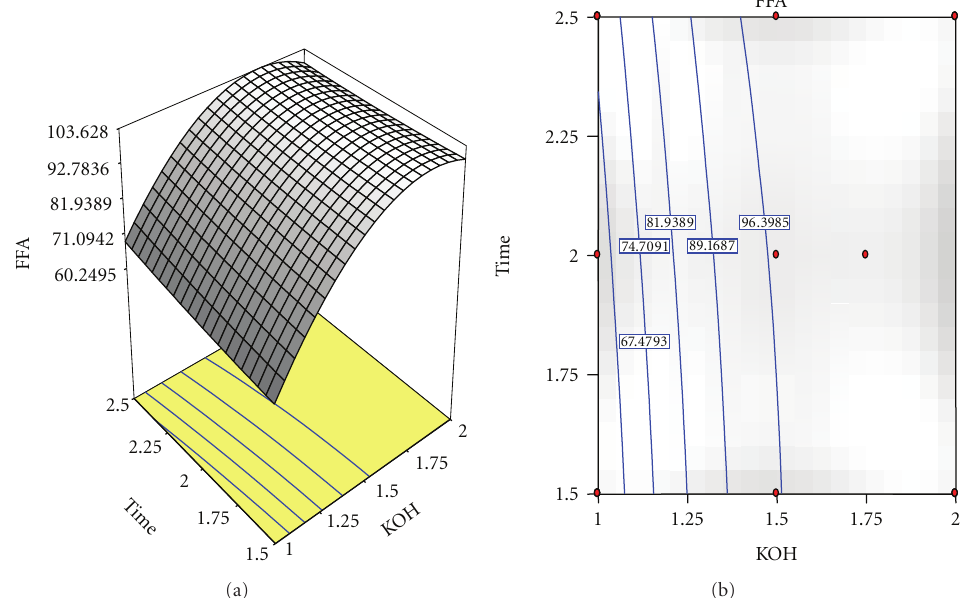
Figure 2: Response surface (a) and contour plots (b) for the e ff ect of the ethanolic KOH ( X 1 , w) and reaction time ( X 3 , h) on the FFA%.